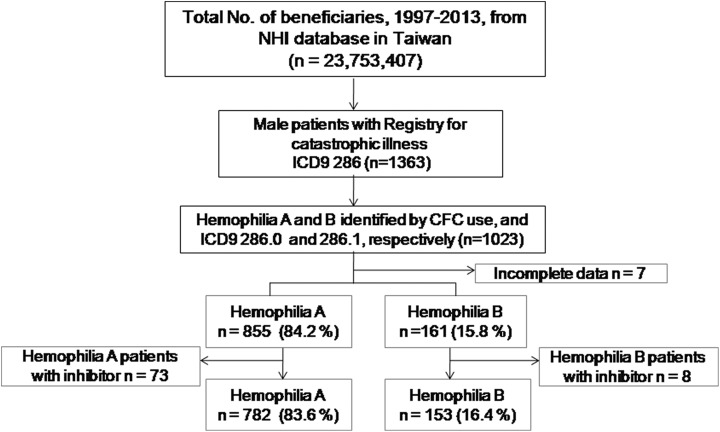
Patient selection. CFC indicates clotting factor concentrate; ICD-9, International
Classification of Diseases, ninth revision; NHI, National Health Insurance.